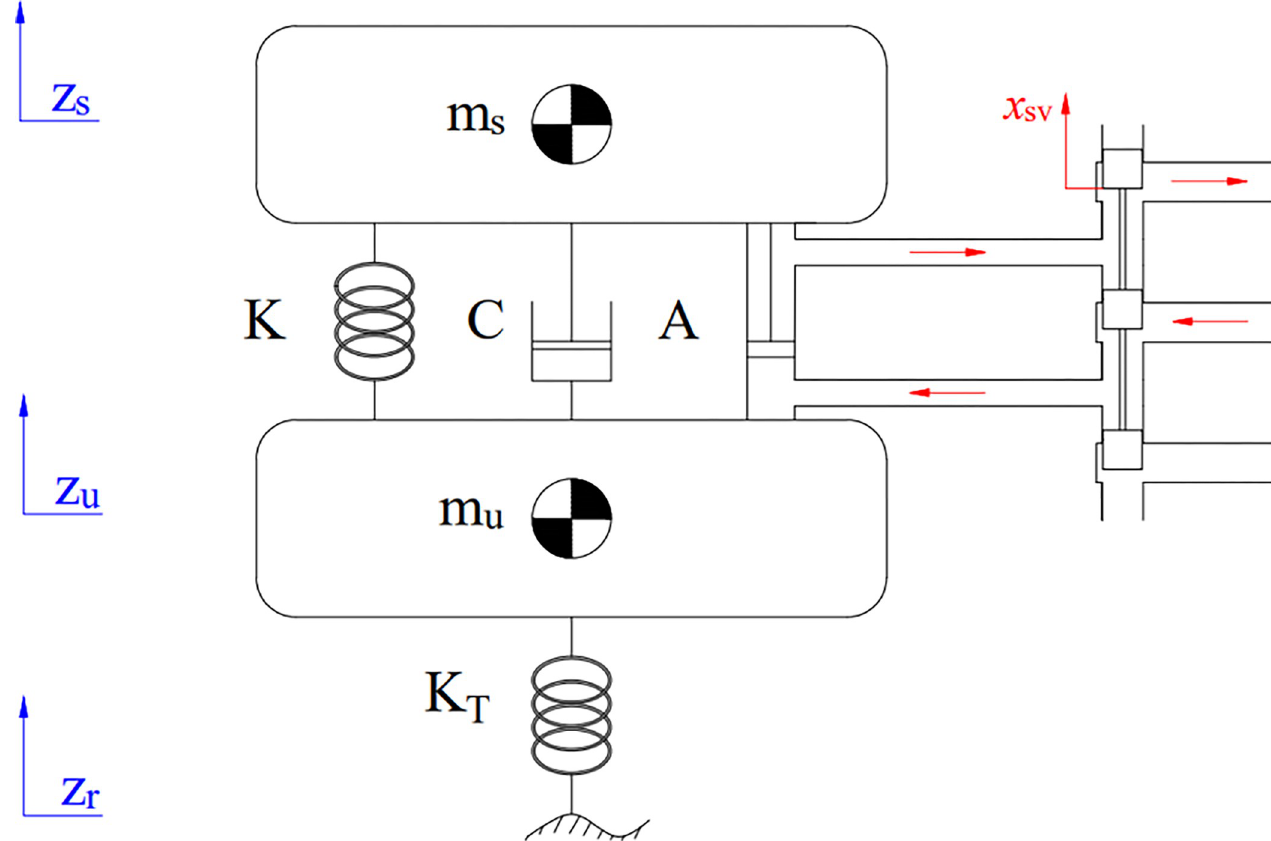
Fig 1. The quarter-dynamics